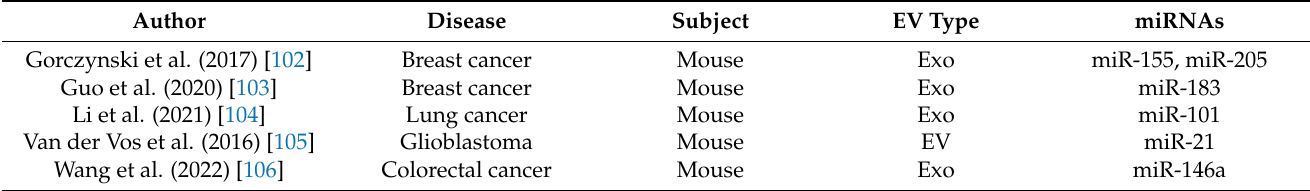
Table 7. Extracellular miRNAs in cancer.